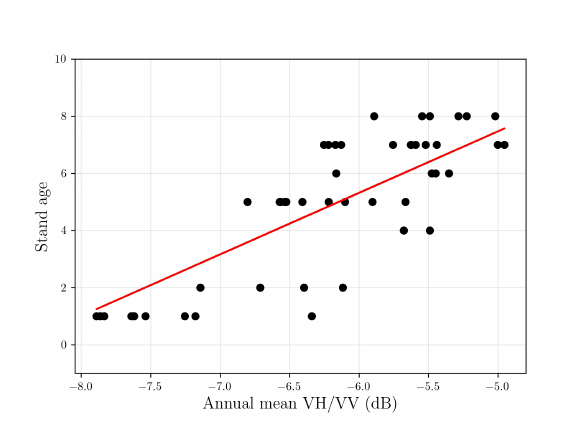
Table 4. Determination coefficients (r 2 ) between annual means of Sentinel-1 backscatter coefficients (dB) and the field-derived stand ages.